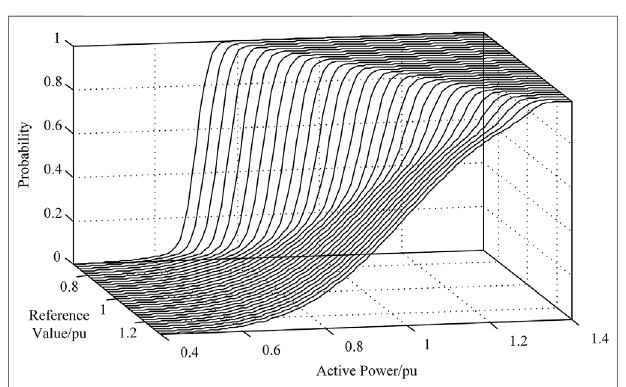
FIGURE 2 | The CDF 3D image of P t PV , ref - ~ P t PV .